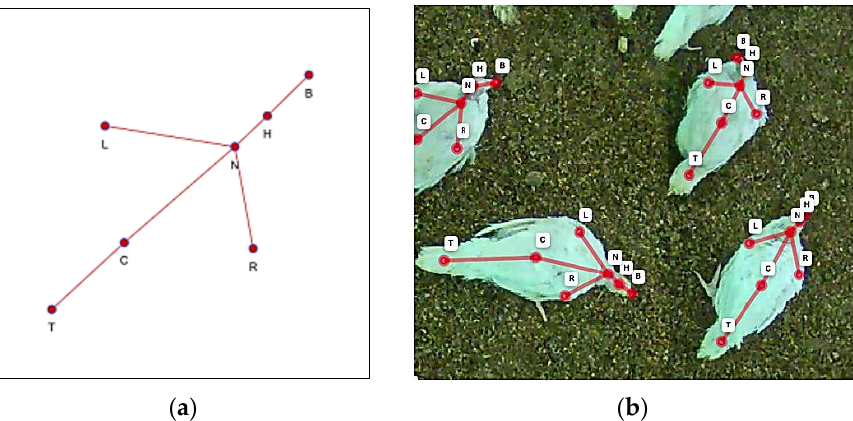
Figure 2. ( a ) Keypoint skeleton showing the beak (B), head (H), neck (N), left wing (L), right wing (R), center of the body (C), and tail (T). ( b ) Example image showing the keypoints on turkey hens.